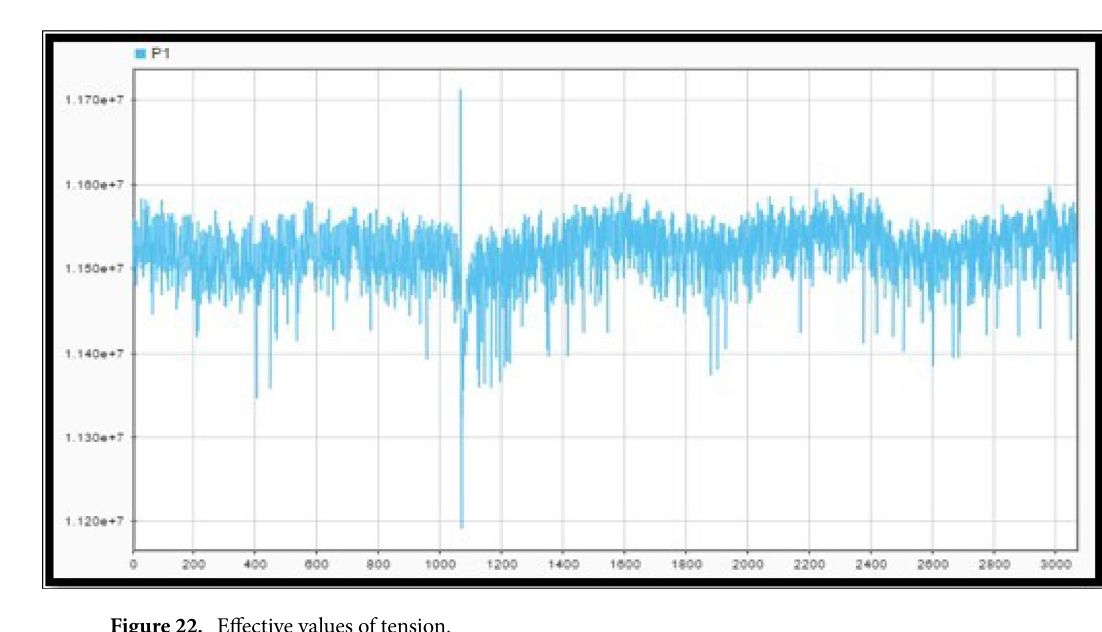
Figure 22. Effective values of tension.